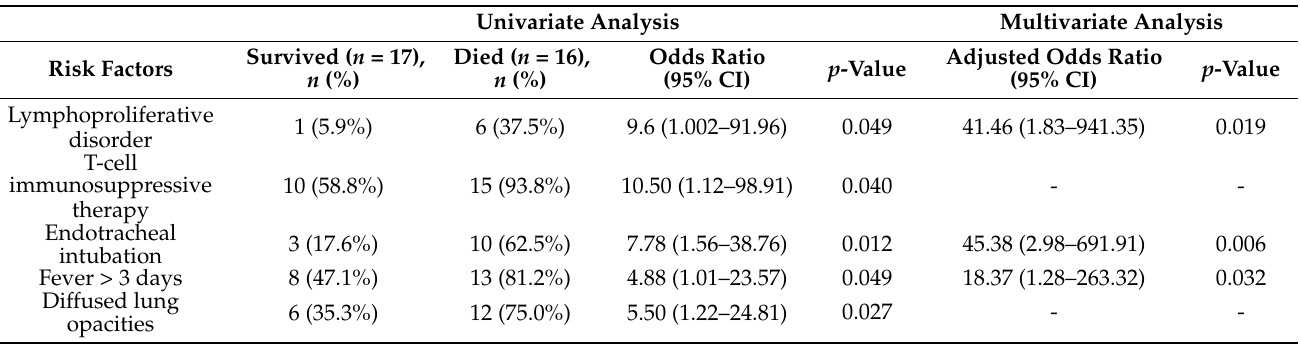
Table 6. Univariate and multivariate analyses for factors significantly associated with mortality in patients with IPA. Univariate Analysis Multivariate